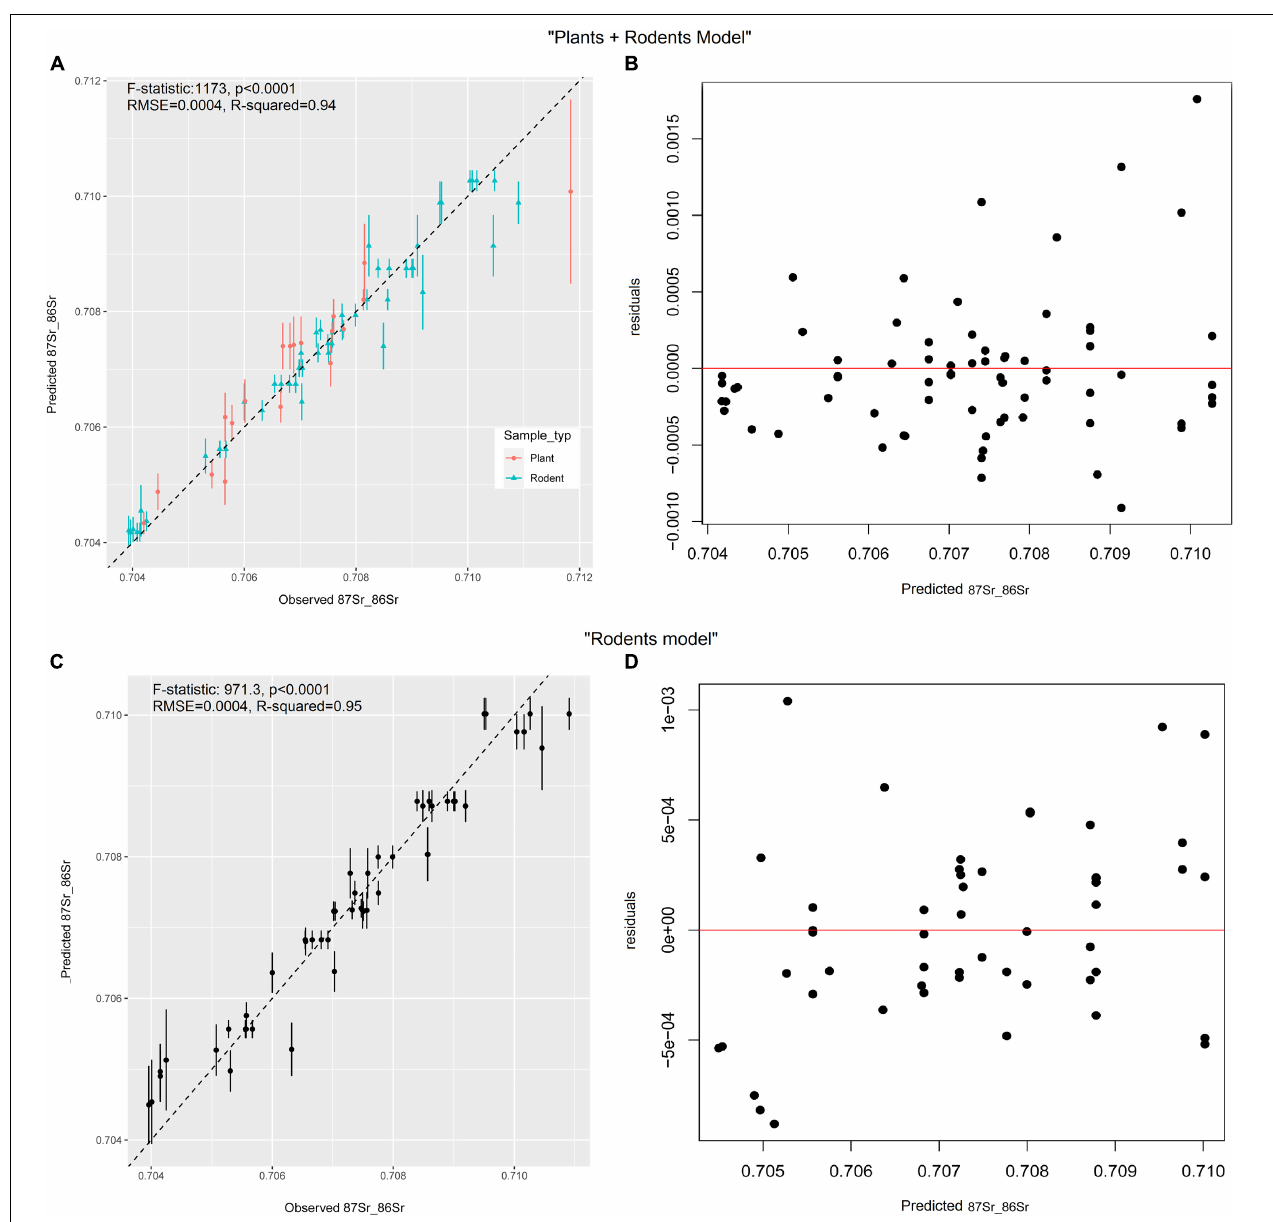
FIGURE 5 | Linear regression between predicted and observed 87 Sr/ 86 Sr values and associated residuals: (A,B) “Plants + Rodents” model. (C,D) “Rodents”